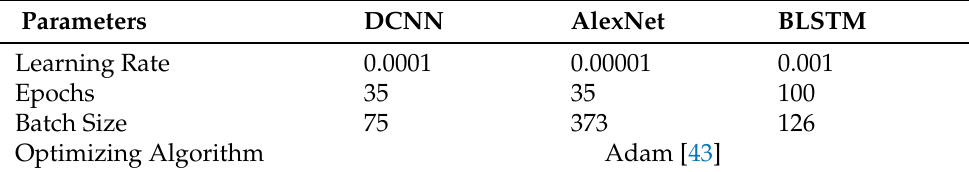
Table 1. Training option of the neural